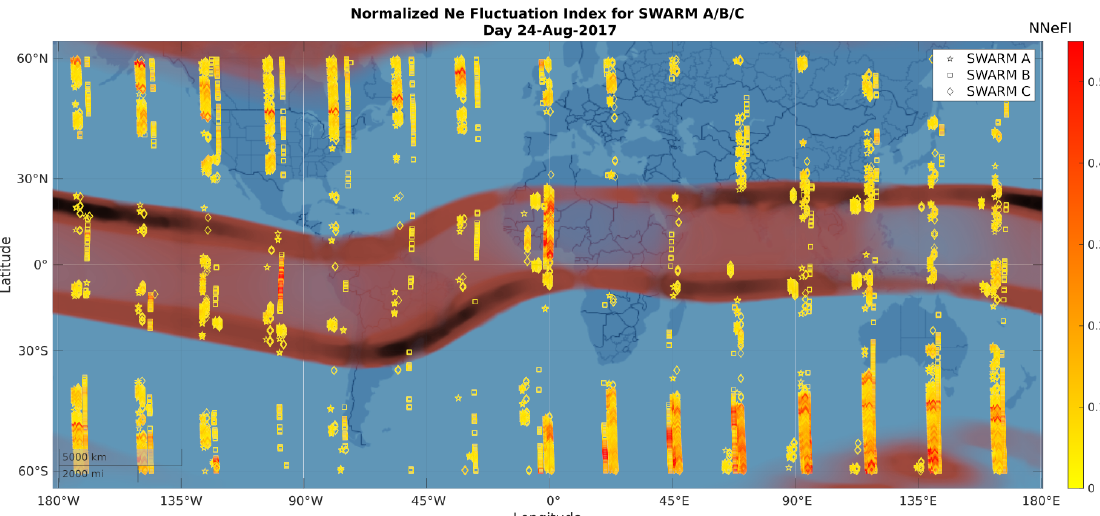
Figure 23. Normalized Ne Fluctuation Index for Swarm A, B and C during 24 August 2017 with the predicted mean occurrence of S 4 scintillation using WBMOD model. Background image adapted from Reference [20] and overlaid with Swarm